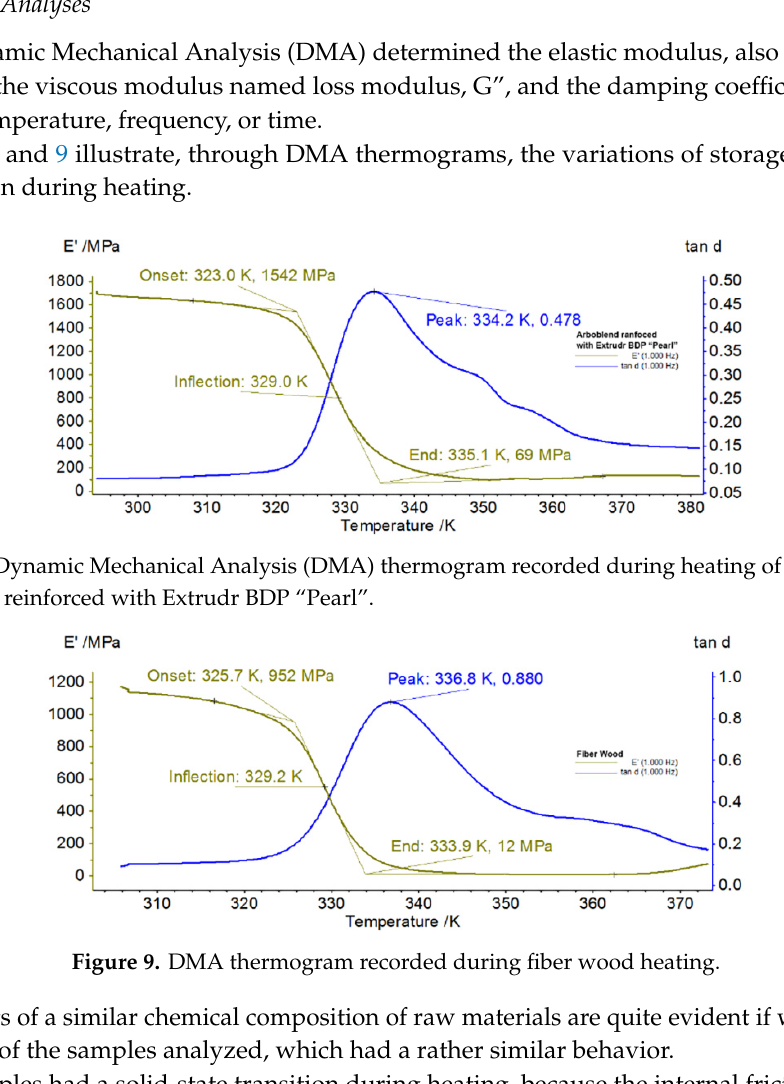
Figure 9. DMA thermogram recorded during fiber wood heating.